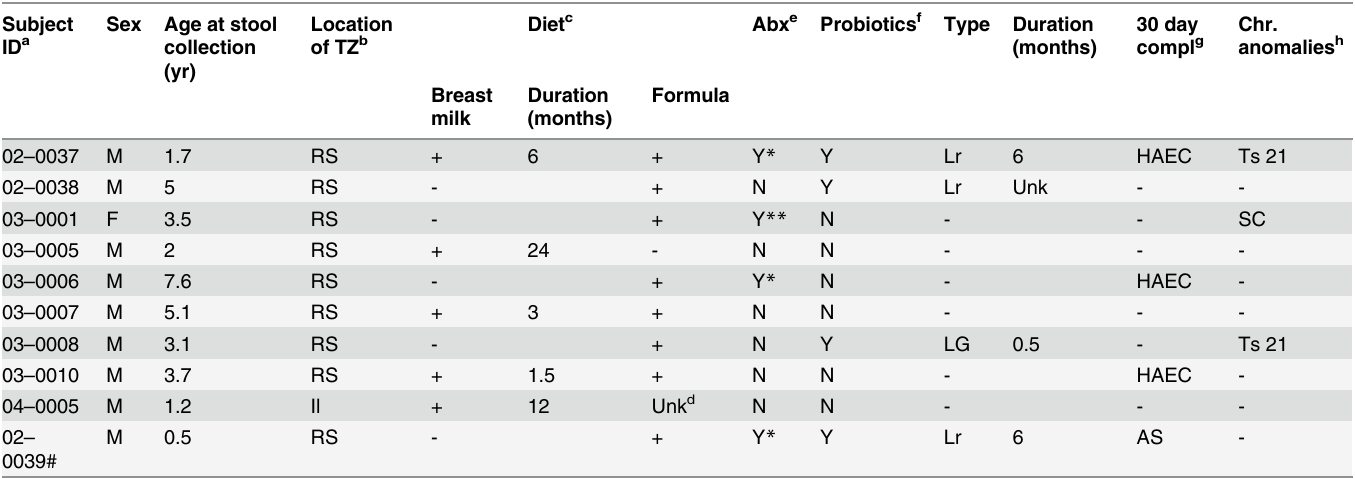
Table 2. Patient Characteristics: